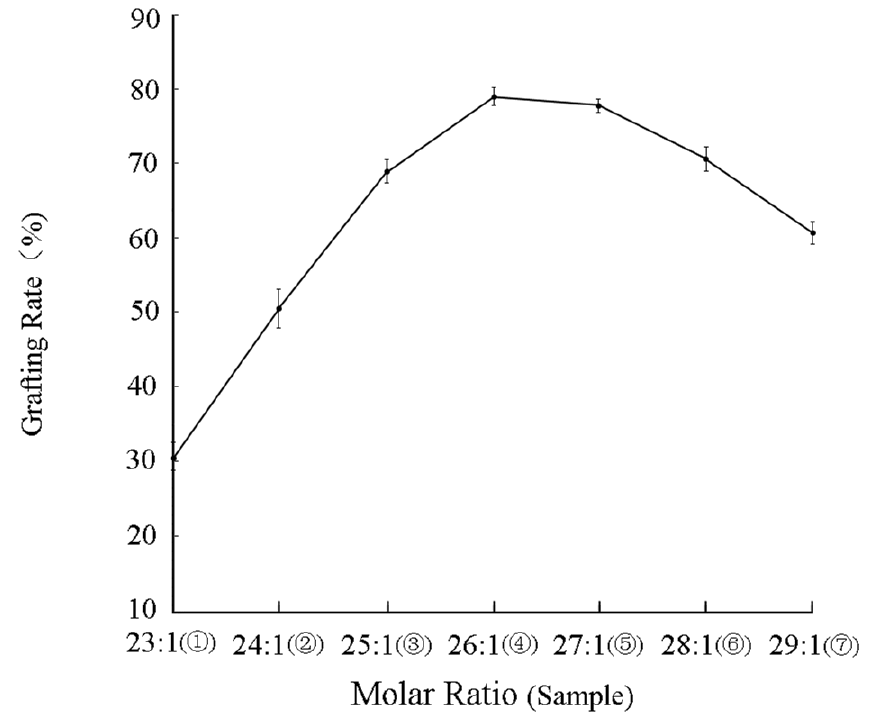
Figure 3. Graft ratio of samples under different molar ratios of epoxy group to DFHMA.